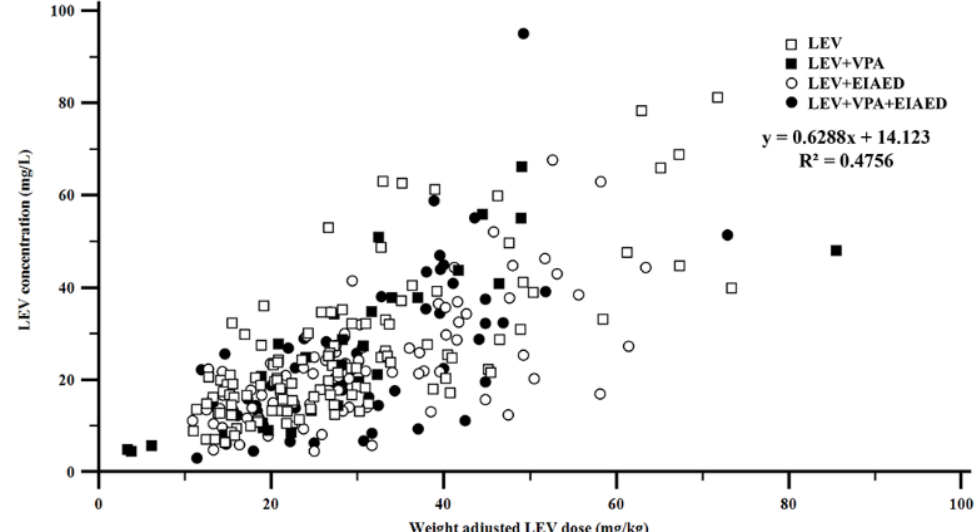
Figure 2. Correlation between weight-adjusted dose and concentration of levetiracetam ( ρ = 0.6896, p < 0.0001, n = 283). Abbreviations: LEV, levetiracetam; VPA, valproic acid; EIAED, enzyme-inducing antiepileptic drug.